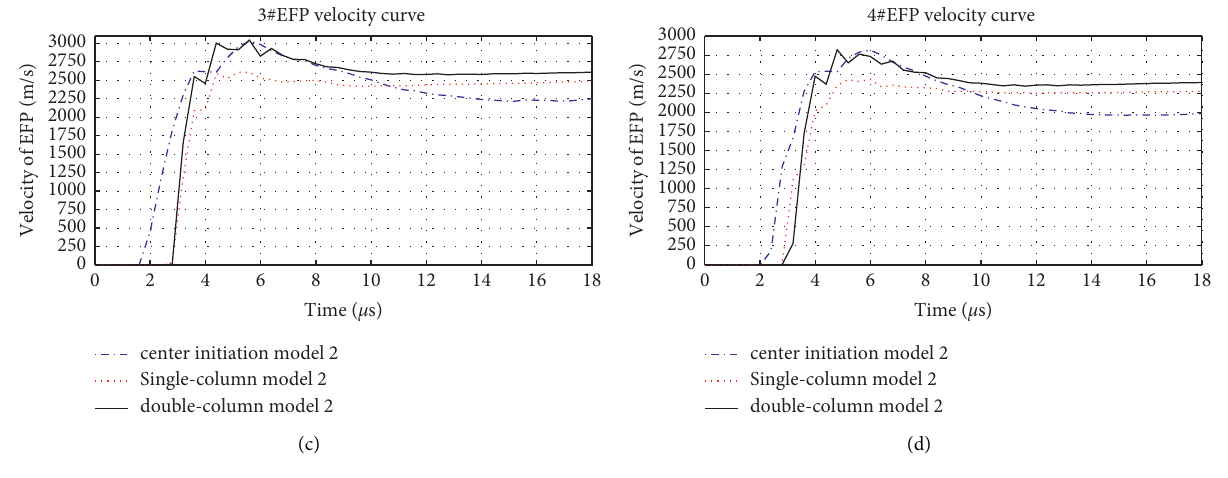
Figure 14: The velocity comparison of the second